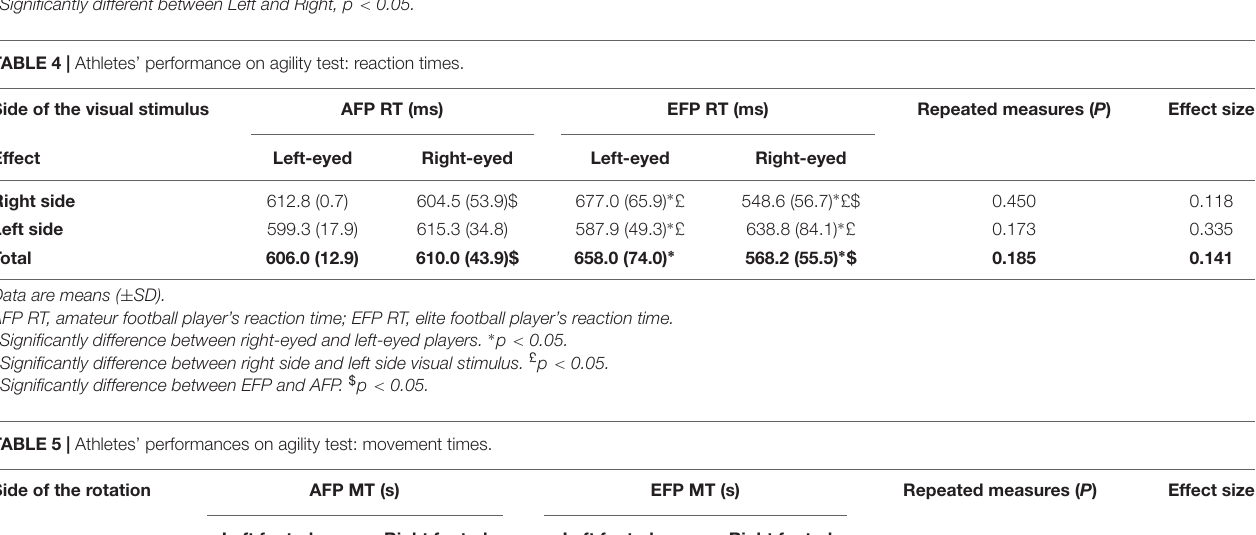
TABLE 3 | Distribution of eyedness, handedness, and footedness in elite football players according to playing positions. Sample n = Eyedness Handedness Footedness Left (%) Right (%) Left (%) Right (%) Left (%) Right (%) Goalkeepers Defenders